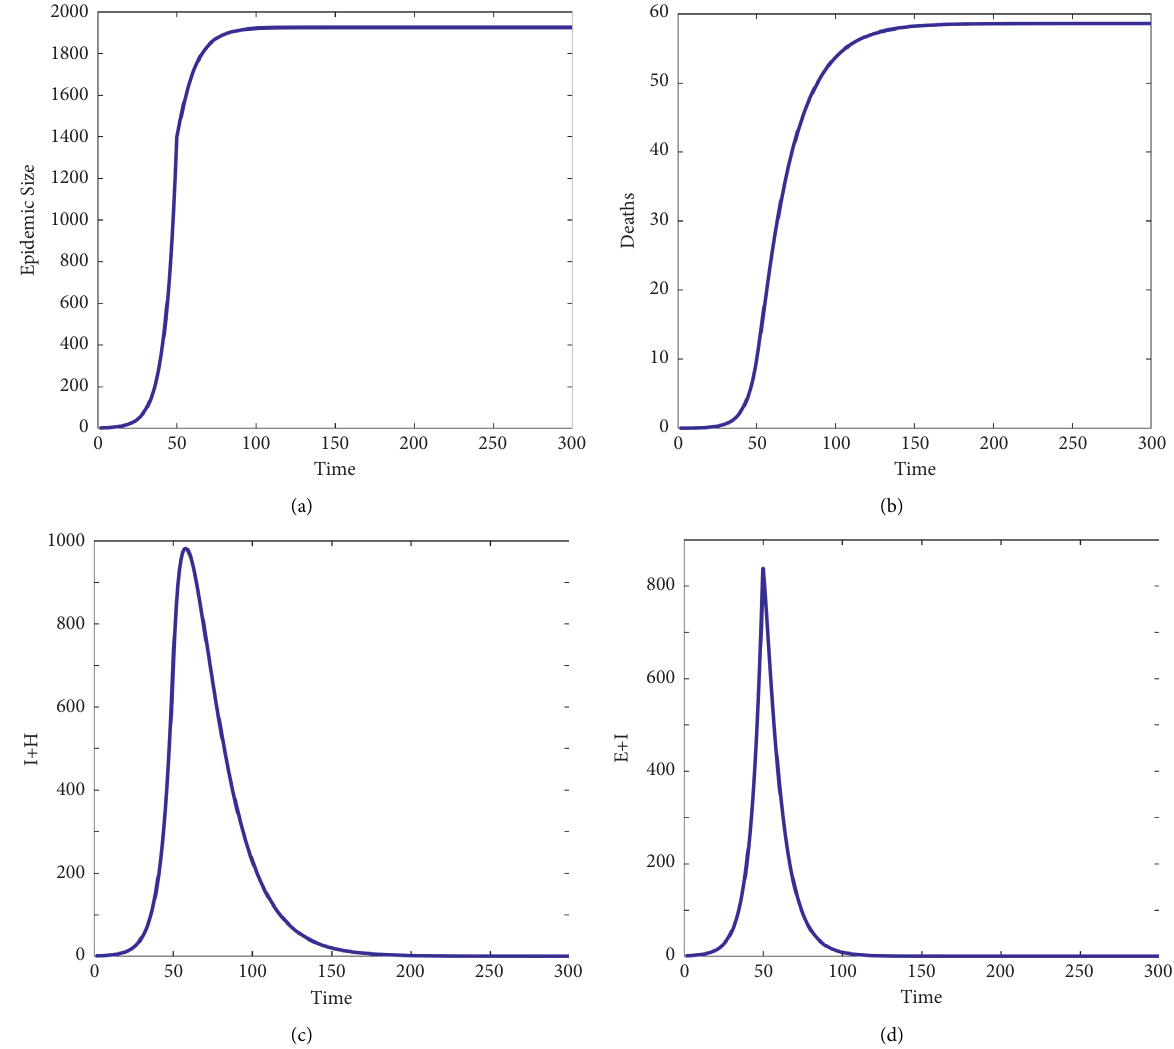
Figure 2: Diagnosis rate ] � 0 . 2, start time of taking measures t (b) the number of deaths, (c) the current number of infections ( I + H ) , and (d) the number of infections that can infect others ( E + I ) over